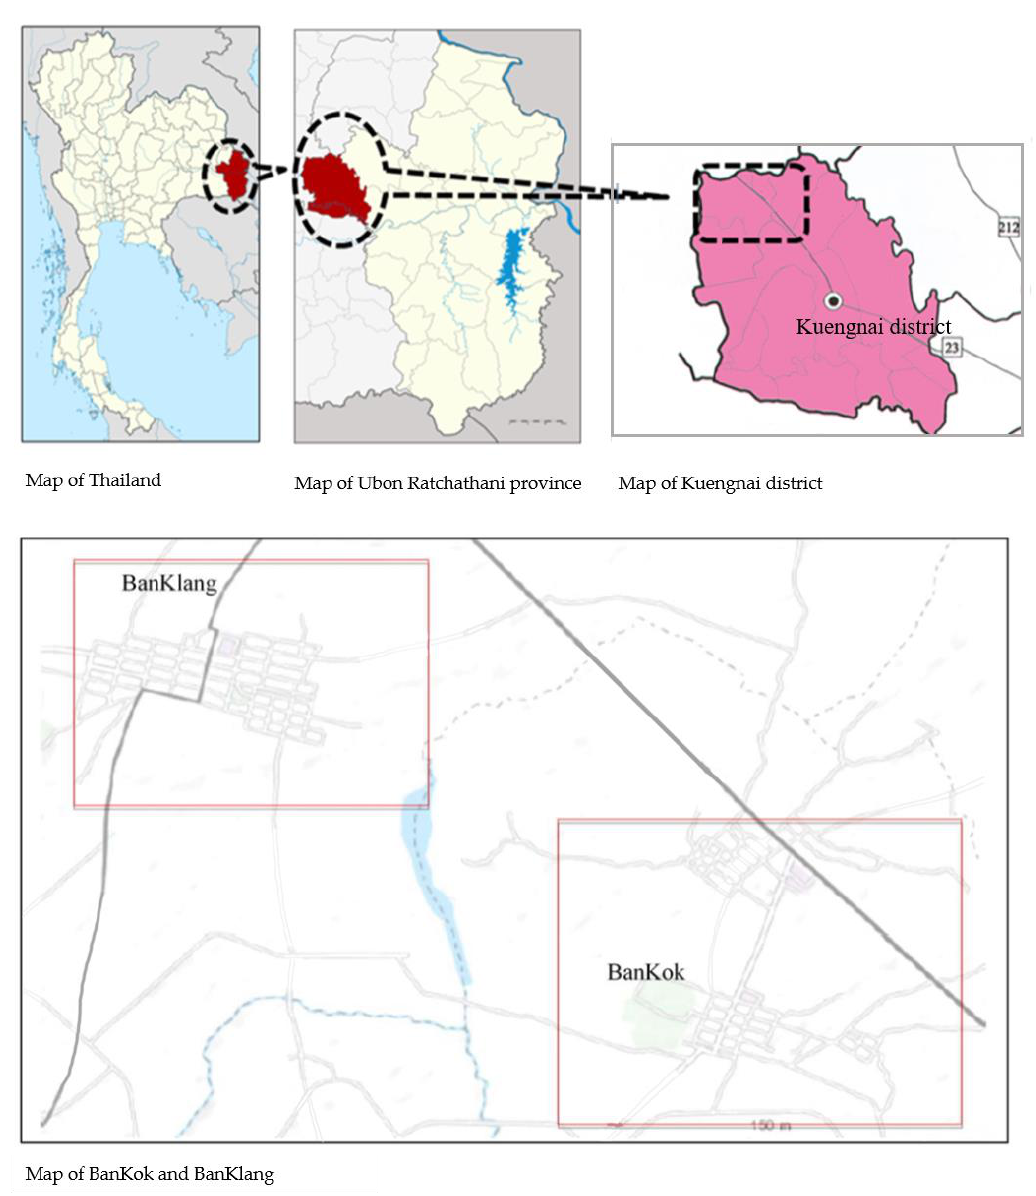
Figure 1. Map of the study sites.